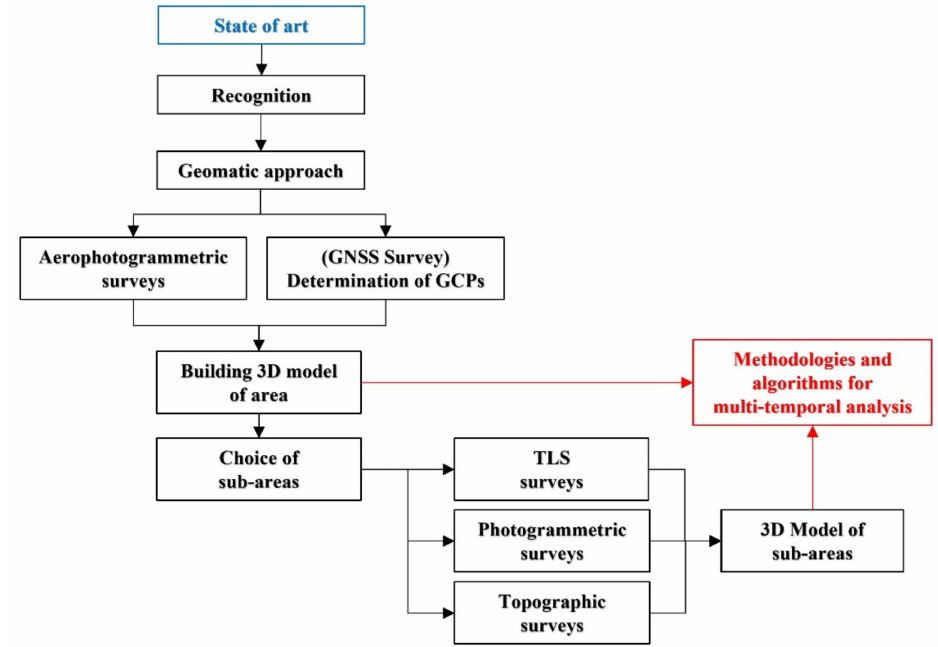
Figure 6. Workflow of implemented method.